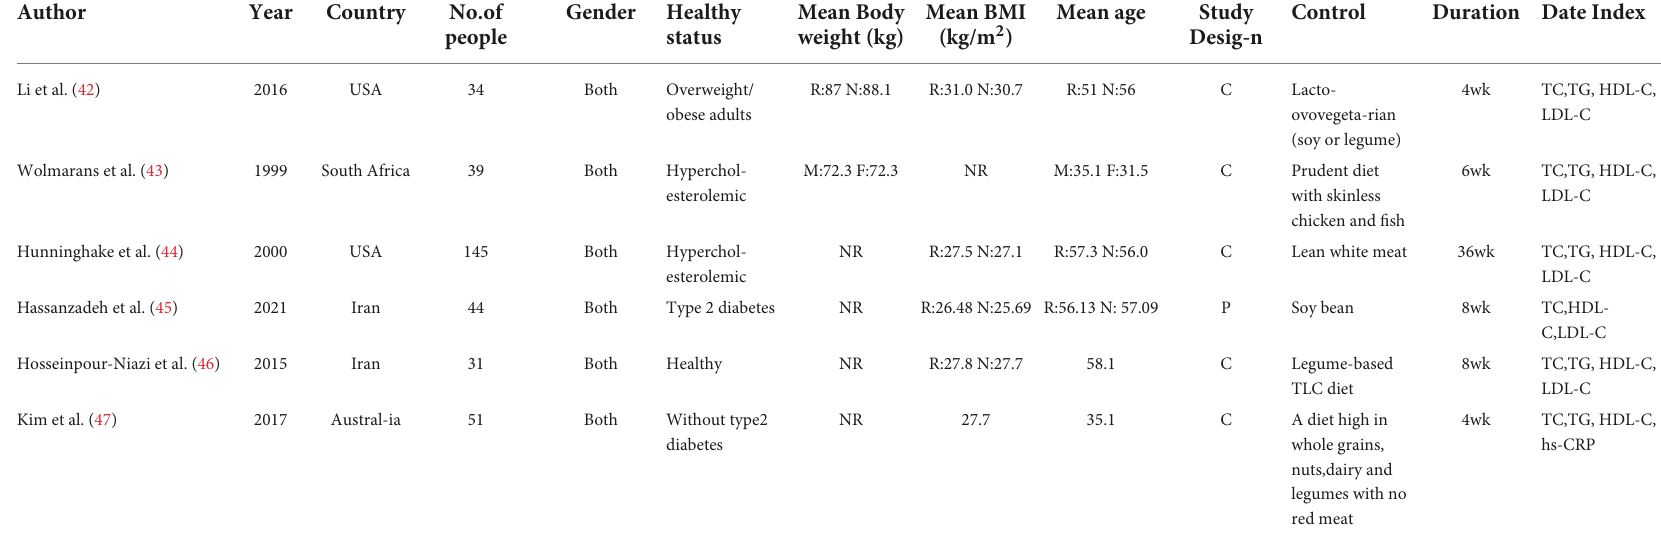
TABLE 4 Characteristics of the 20 RCT studies